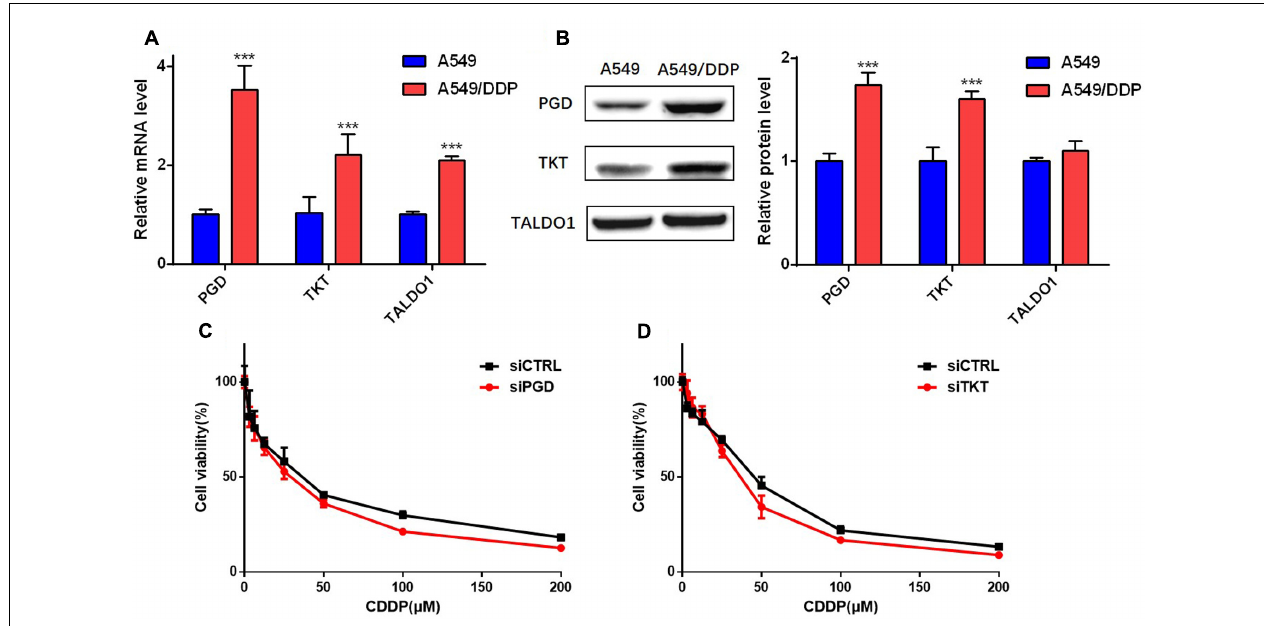
FIGURE 7 | Other major enzymes of the PPP did not participate in the cisplatin resistance of A549/DDP cells. (A,B) The mRNA and total protein levels of PGD, TKT and TALDO1 were assessed in A549 and A549/DDP cells. The control GAPDH band is shown in Figure 3B . (C,D) A549/DDP cells transfected with siRNA were cultured for 48 h with various concentrations of cisplatin (3.125–200 µ M), and cell viability was determined. Data are represented as the means ± SD ( n = 3), and significant differences are indicated as ∗ P < 0.05, ∗∗ P < 0.01, and ∗∗∗ P < 0.001.